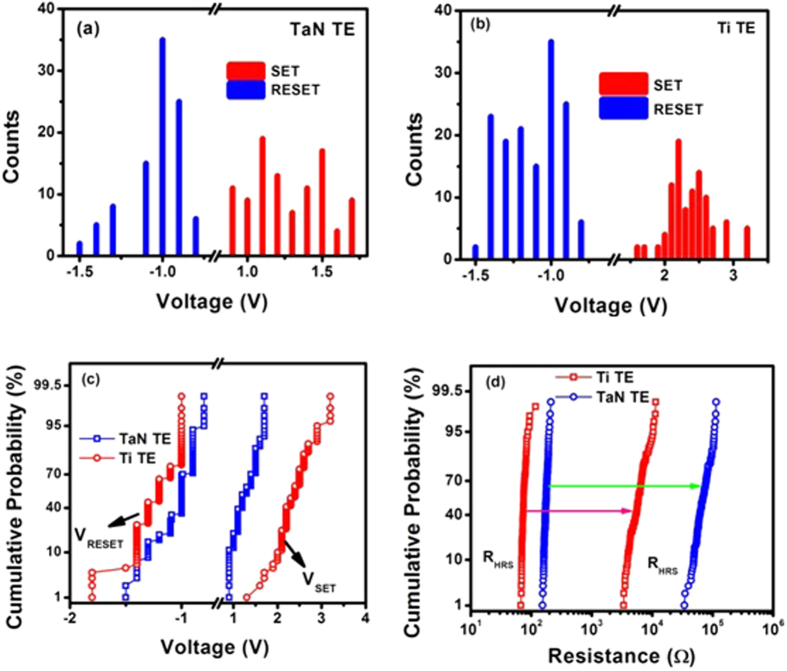
Statistical and cumulative probability distribution of Vset and Vreset voltages measured from a device unit for first 100 tests.(d) RLRS and RHRS measured under DC voltage sweeps for both TaN and Ti TE based devices.